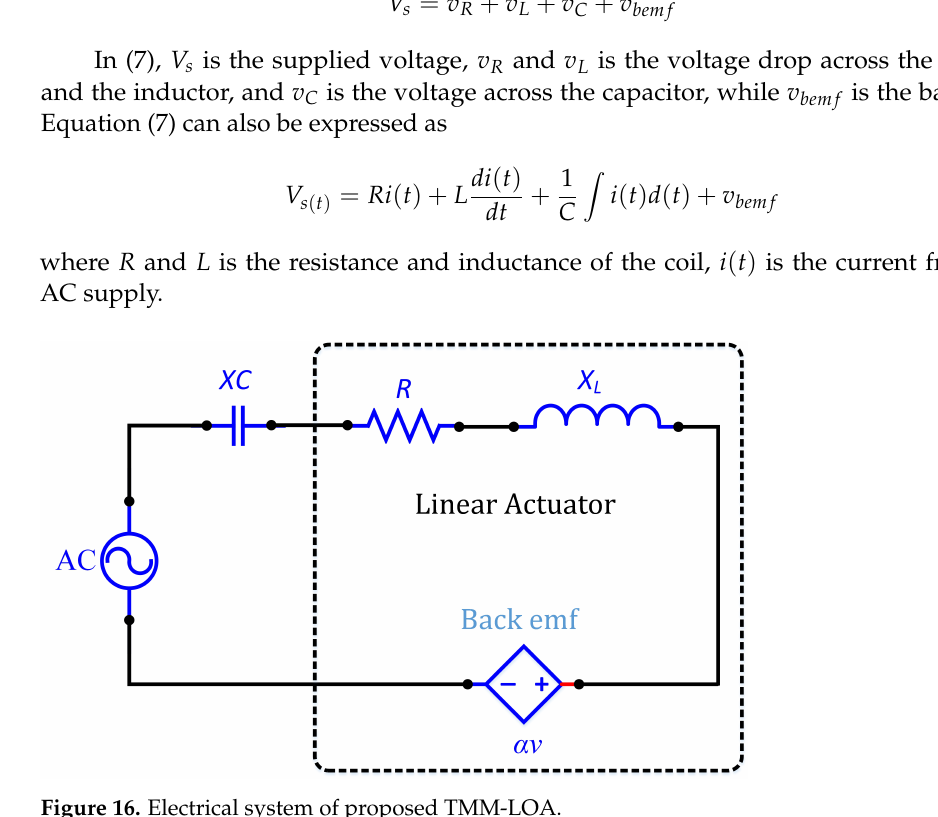
Figure 16. Electrical system of proposed